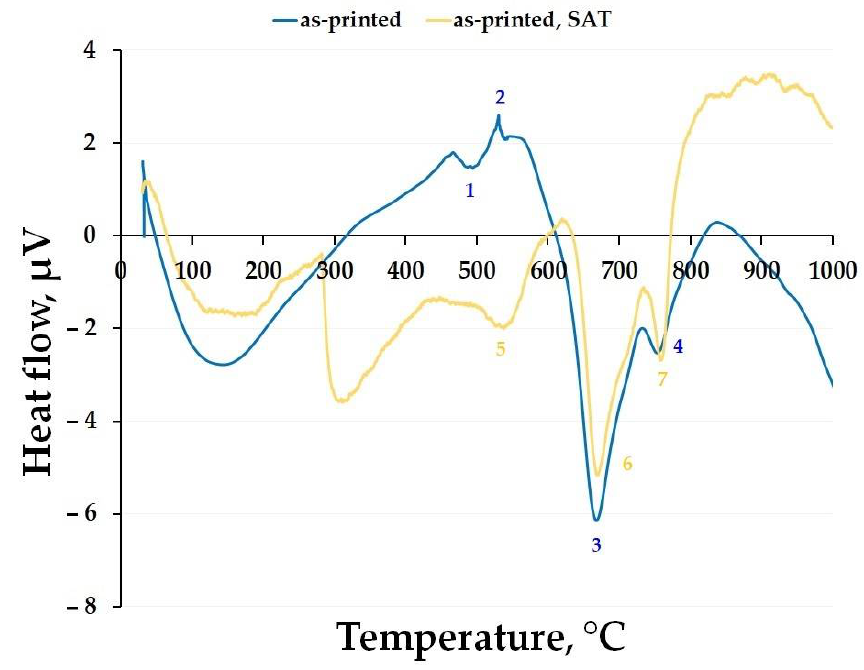
Figure 4. DTA curves for 1.2709 maraging steel depending on the heat treatment (identified peaks are labeled with numbers).